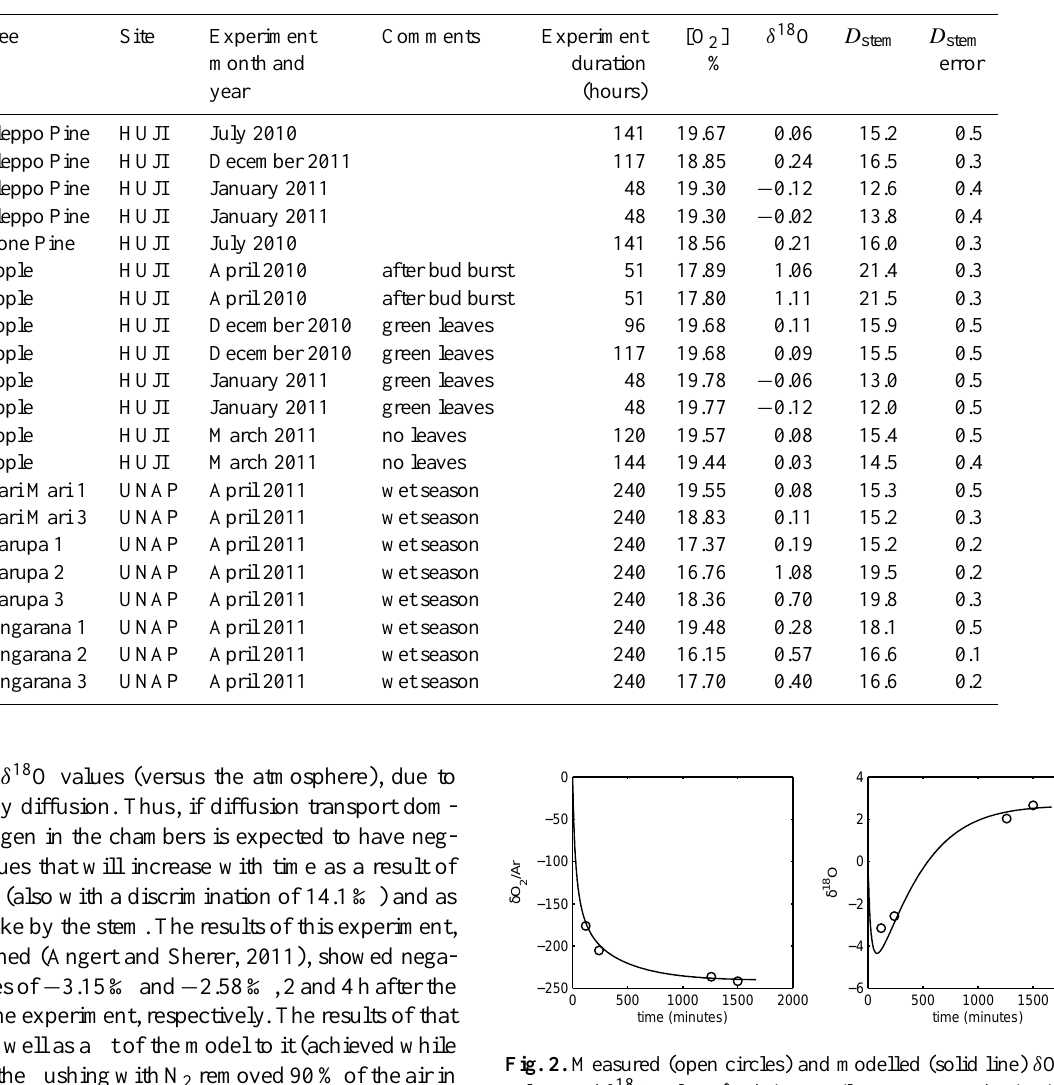
Fig. 2. Measured (open circles) and modelled (solid line) δ O 2 /Ar values and δ 18 O values (both in permil versus atmospheric air) dur- ing the experiment which started with flushing the chamber on the Apple tree with N 2 . The model assumes constant respiration rate and discrimination. The results of this experiment are consistent with diffusion being the main driver of gas exchange in the